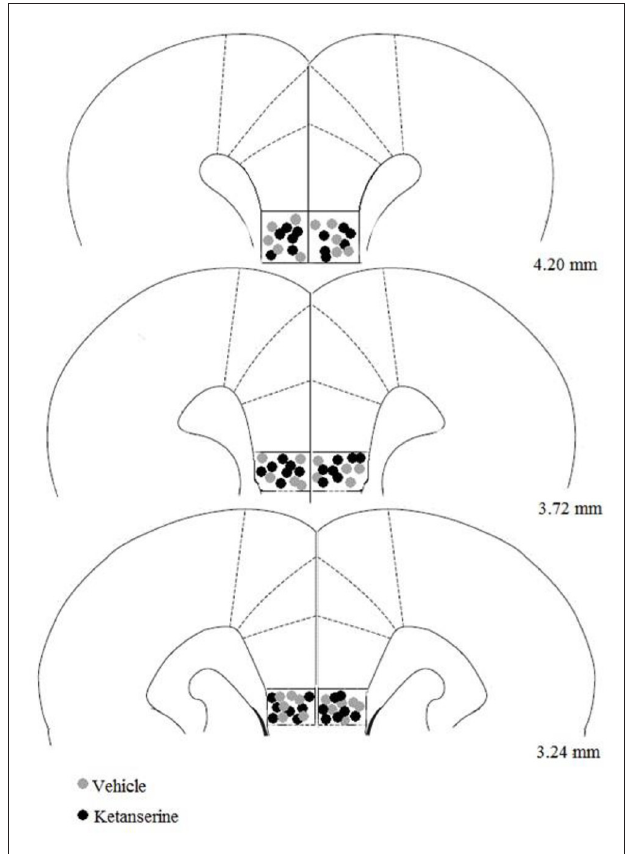
FIGURE 2 | Site of microinjection tips in the infralimbic (IL) cortex. Gray square indicates site of vehicle injection. Black circle indicates site of ketanserin injections. Plates are taken from Paxinos and Watson (1986) and the numbers on the right side of each plate indicate the distance (in millimeters) from bregma.